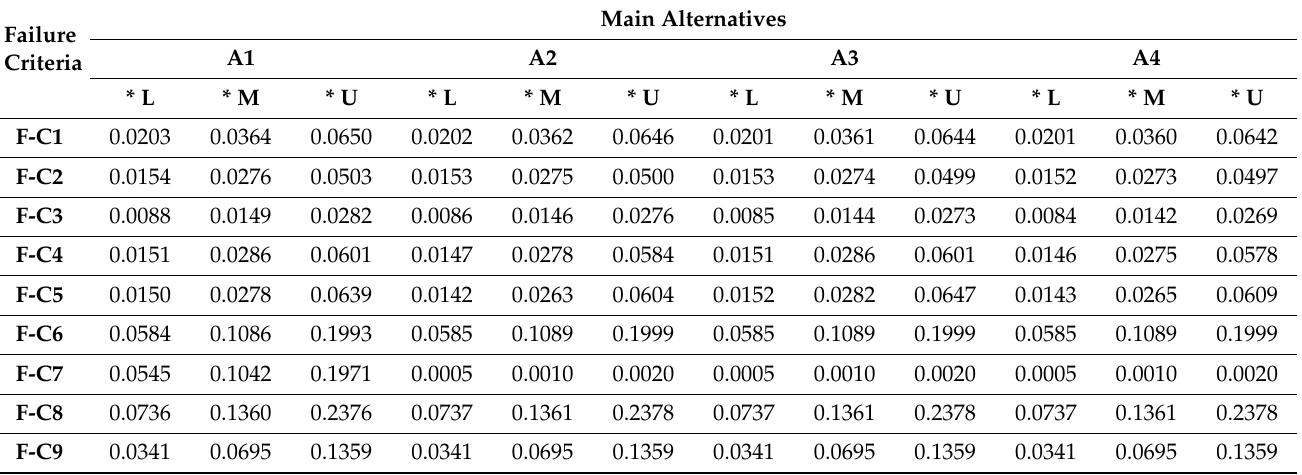
Table 12. The specific normalised decision matrix table with fuzzy elements for all the main alterna- tives at 50% of cyclic loading